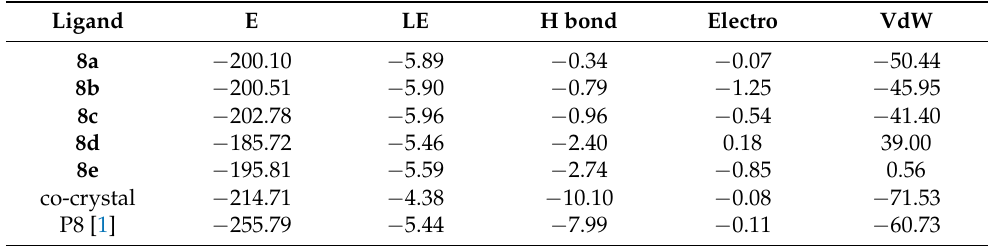
Table 1. Main interaction energies between the studied molecules and the SARS-CoV-2-M Pro *. Ligand